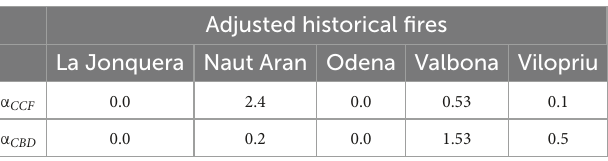
TABLE 1 Coefficients reflecting the impact of canopy characteristics on the spread of crown fires, for each historical fire. Adjusted historical